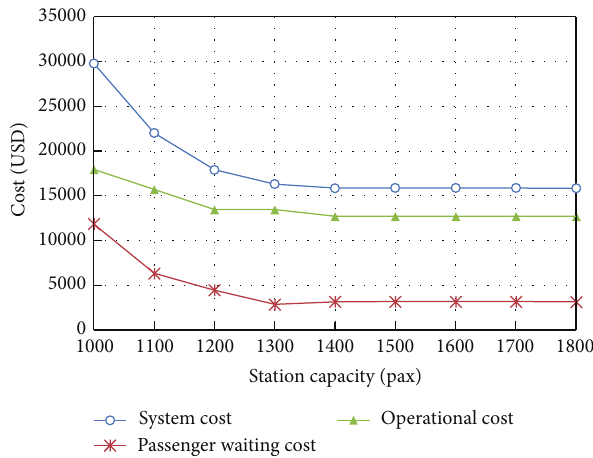
Figure 14: Optimal values with different station